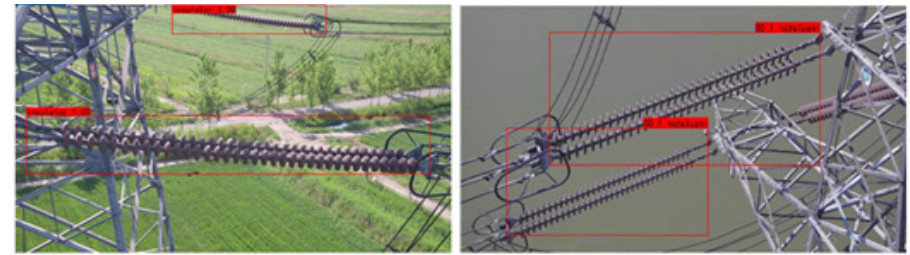
Figure 11. Insulator test results of the improved faster